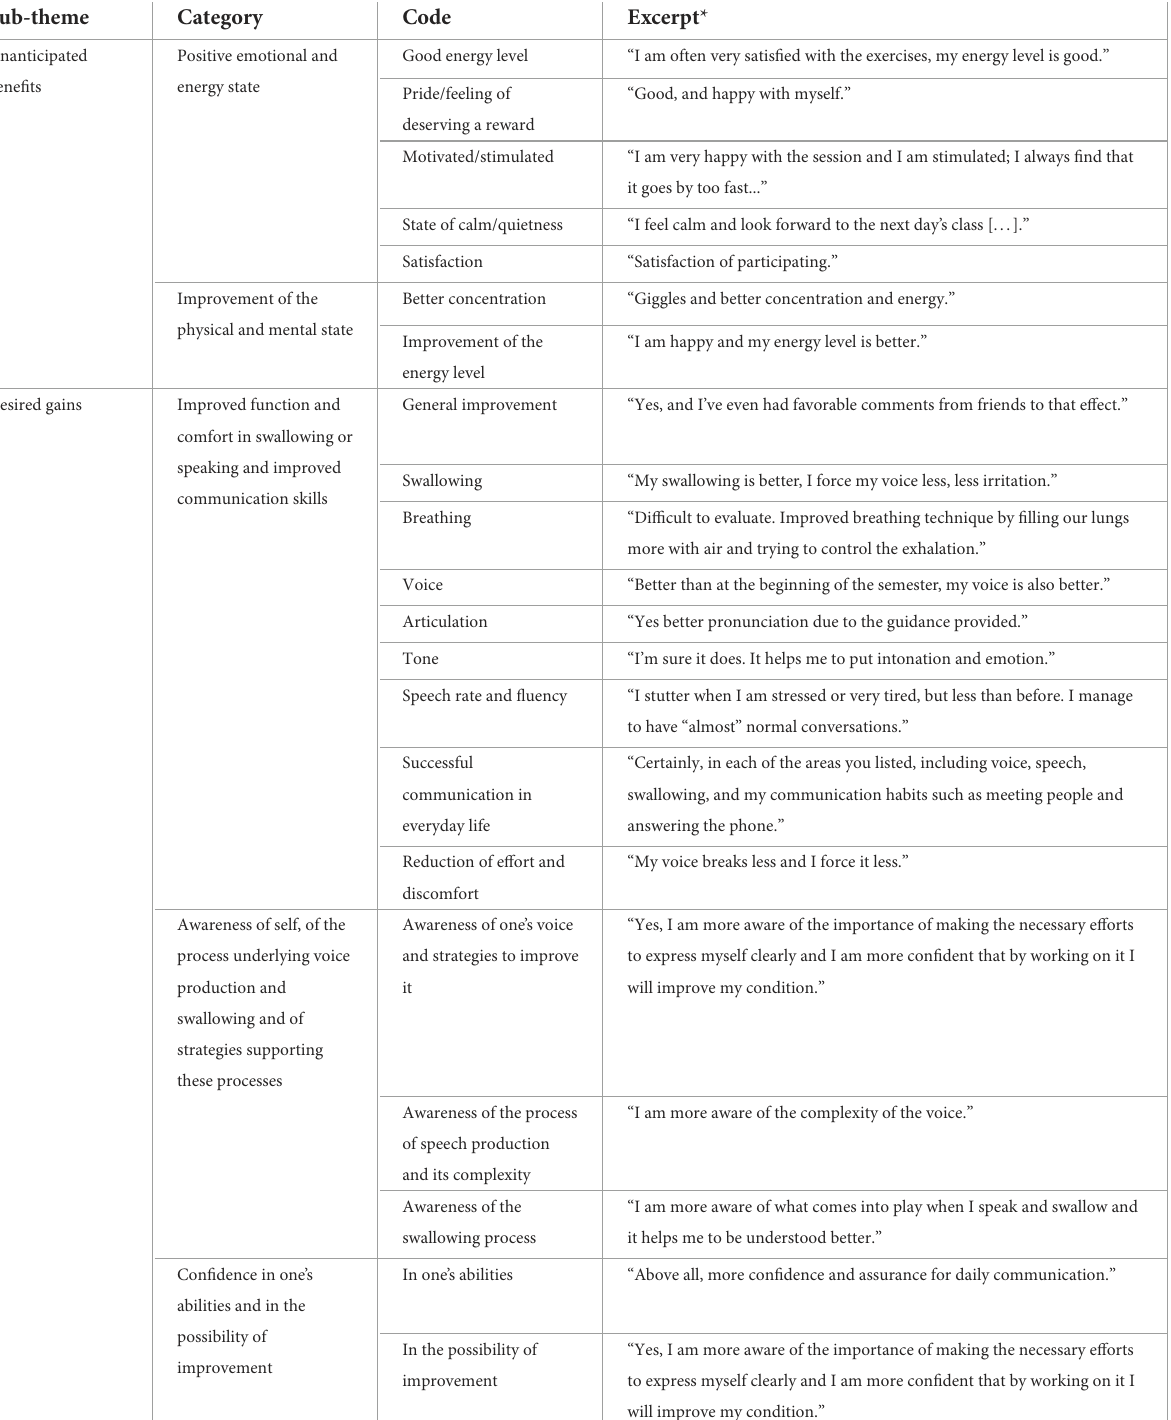
TABLE 4 Unanticipated benefits and desired gains catalyzing motivation to participate in MdlV. Sub-theme